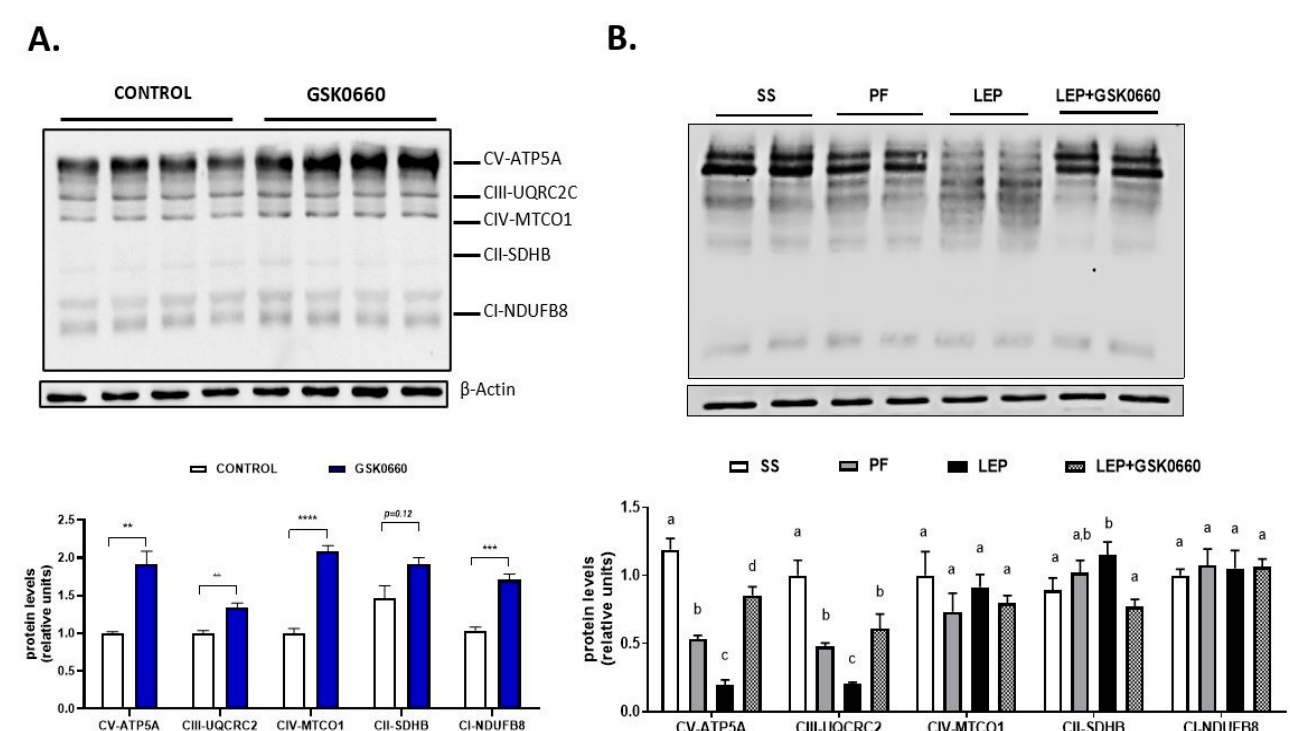
Figure 7. ( A ) Representative Western Blot of OXPHOS complexes 1–5 and relative densitometric analysis in eWAT of rats after 7 days of vehicle (DMSO) control or intraperitoneal antagonist GSK0660 injection ( n = 6). ( B ) Representative Western blot of OXPHOS complexes 1–5 and relative densitometric analysis in eWAT of rats after 7 days of chronic central treat- ment of vehicle (SS and PF), leptin, or leptin and ip GSK0660 co-administration ( n = 4–6). Densitometric levels of proteins